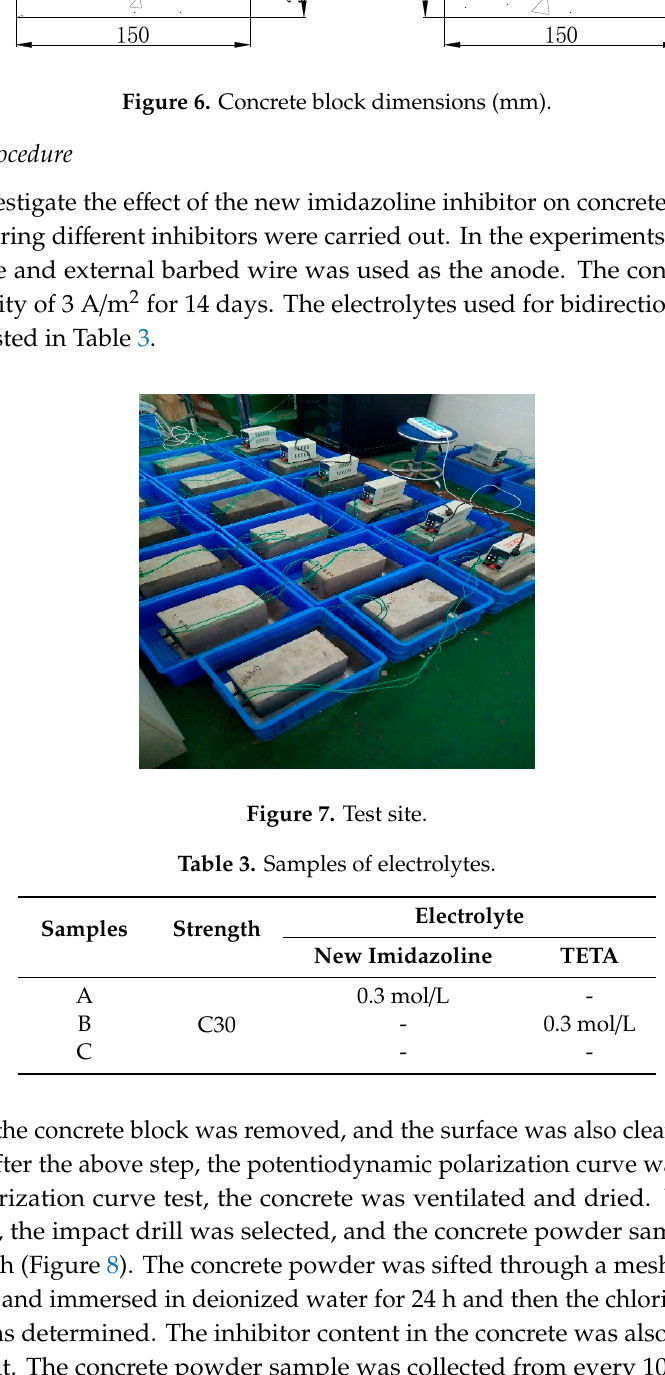
Figure 6. Concrete block dimensions (mm). Table 3. Samples of electrolytes.